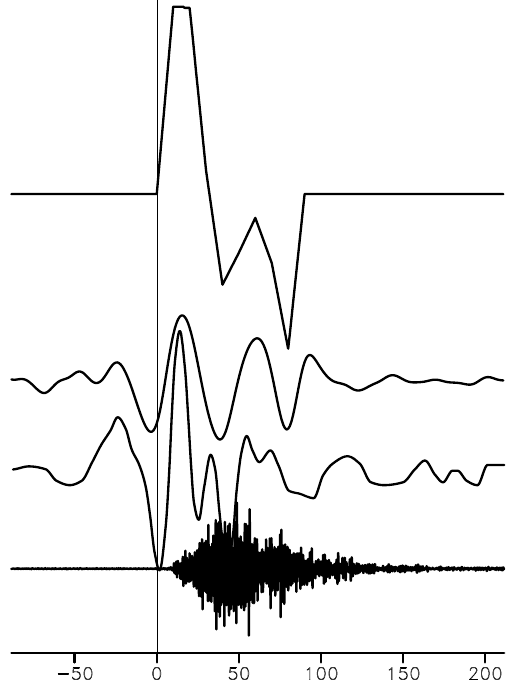
Figure A2. Same as Fig. A1, but showing the E–W force history. Figure A3. Same as Fig. A1, but showing the U–D force